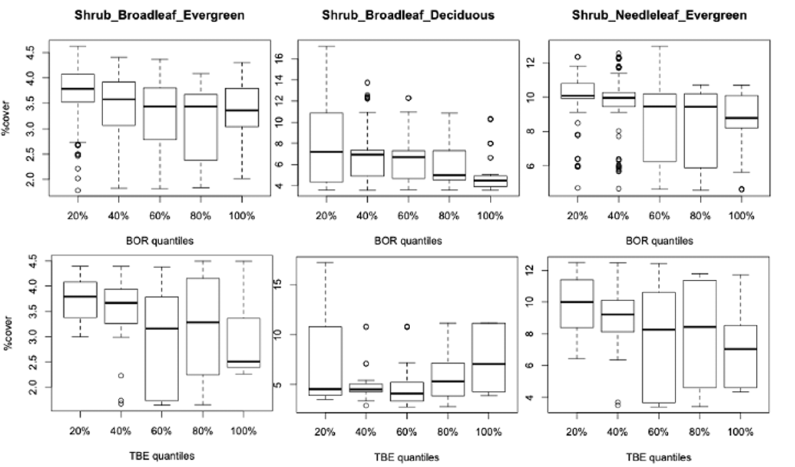
Figure 6. Boxplots for the shrub cover fractions for the WI districts per quantile range of disease incidence. Surface interpolations were used to analyse the yearly evolution of the potential associations between managed grass and both diseases (Figure 8). For 35 WI BOR districts, a greater managed grass cover is linked with a high incidence in the later years, but this fades away when all 69 districts are considered. For TBE, a large zone of low incidence (light blue) in 1996–2005 occurs for WI districts but not for all districts, indicating a clear bimodal distribution at 4% and 26% of fraction cover for the 23 WI districts, but this is only weakly present for all 59 districts.